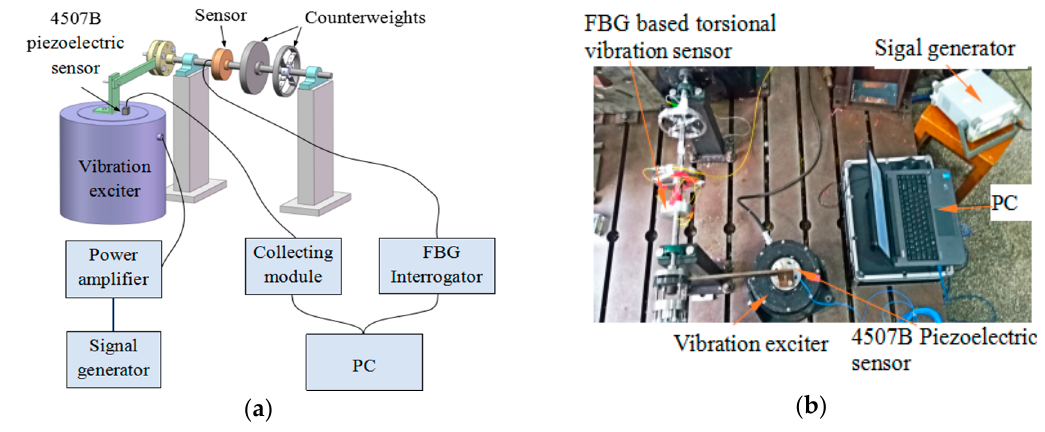
Figure 7. ( a ) The schematic diagram and ( b ) photograph of sensing characteristics experiments for the FBG-based torsional vibration sensor. FBG-based torsional vibration